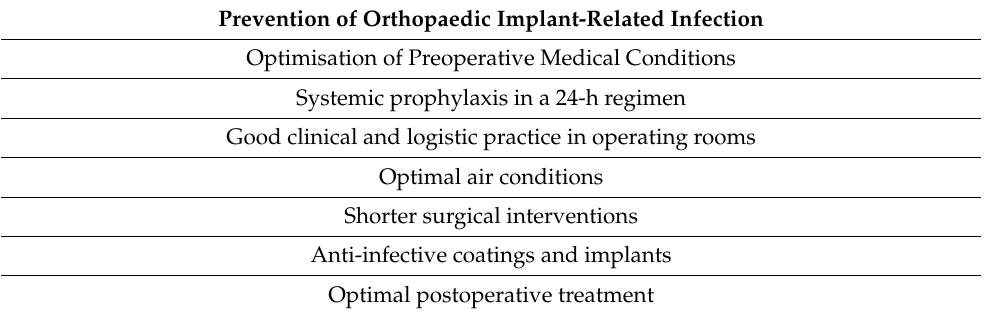
Table 1. Prevention of orthopaedic implant-related